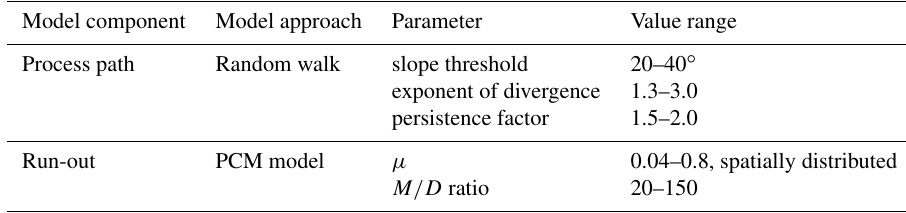
Table 3. Model configuration for debris flow modeling on a regional scale and approximate parameter ranges (compiled from Zimmermann et al., 1997; Gamma, 2000; Wichmann and Becht, 2005; Wichmann,